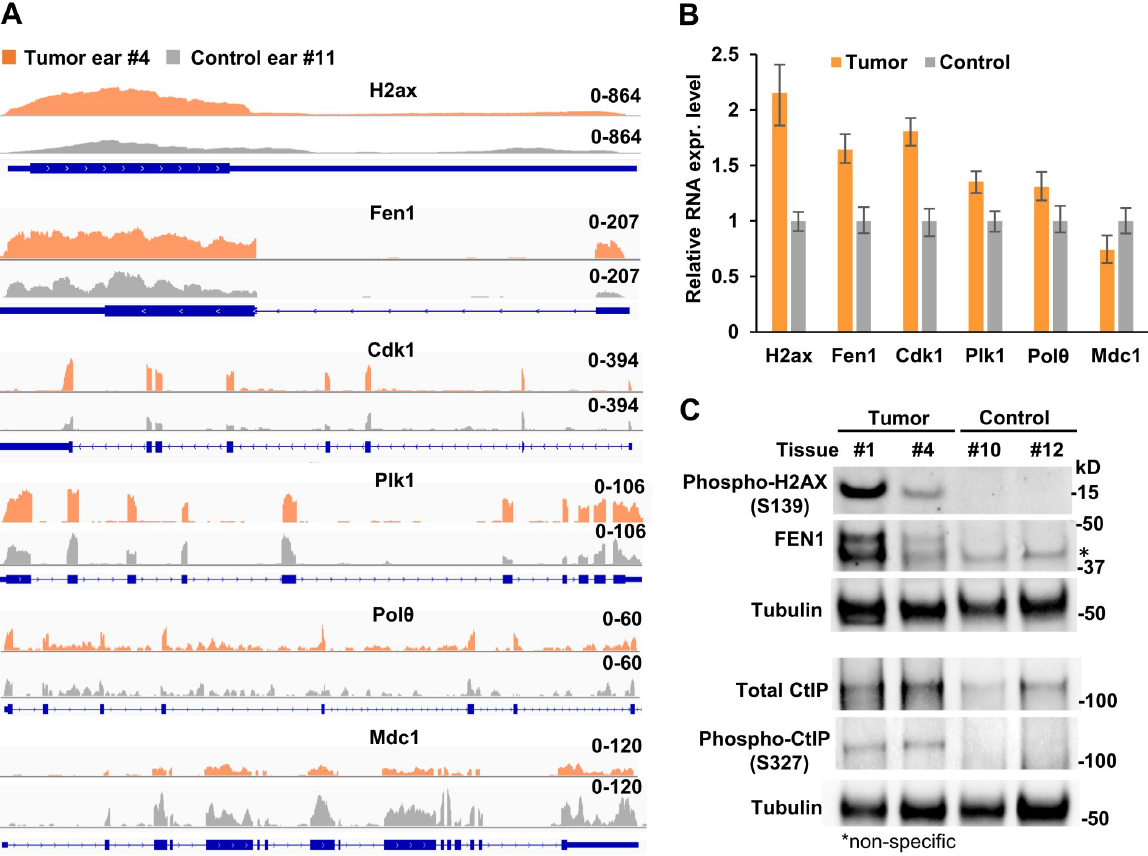
Fig 8. Expression of host DNA repair factors in the MmuPV1-induced tumor and MmuPV1-infected, tumor-free tissues. A, Distributions of mapped RNA-seq reads for H2ax, Fen1, Cdk1, Plk1, Pol θ , and Mdc1 in tumor (Sample #4) and tumor-free (sample #11) ear tissues ( see Fig 2B ) to the mouse genome were visualized by IGV. B, Quantitative RNA expression for H2ax, Fen1, Cdk1, Plk1, Pol θ , and Mdc1 from ear tissues by RT- qPCR. Total RNA extracted from MmuPV1 tumor (sample #4) and tumor-free (sample #11) ear tissues from animal #2 ( See Fig 2B ). The RNA expression levels of the indicated genes were determined by RT-qPCR using mouse gene-specific TaqMan probes. C, Phosphor-H2AX (S139) ( γ H2AX), FEN1, CtIP, and phosphor-CtIP (S327) in tumor samples #1 and #4 and tumor-free samples #10 and #12) ( see Fig 2B ) were determined by Western blot using the indicated antibodies. Tubulin served as a sample loading